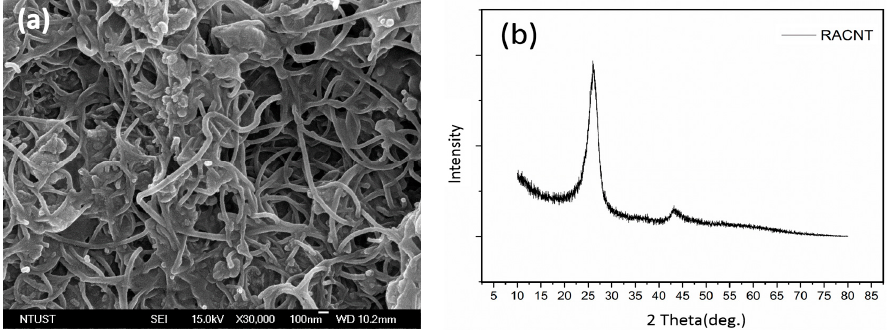
Figure 3. ( a ) The field emitted SEM images of carbon nanotubes is random alignment magnified 30,000 times; ( b ) XRD patterns of RACNT.